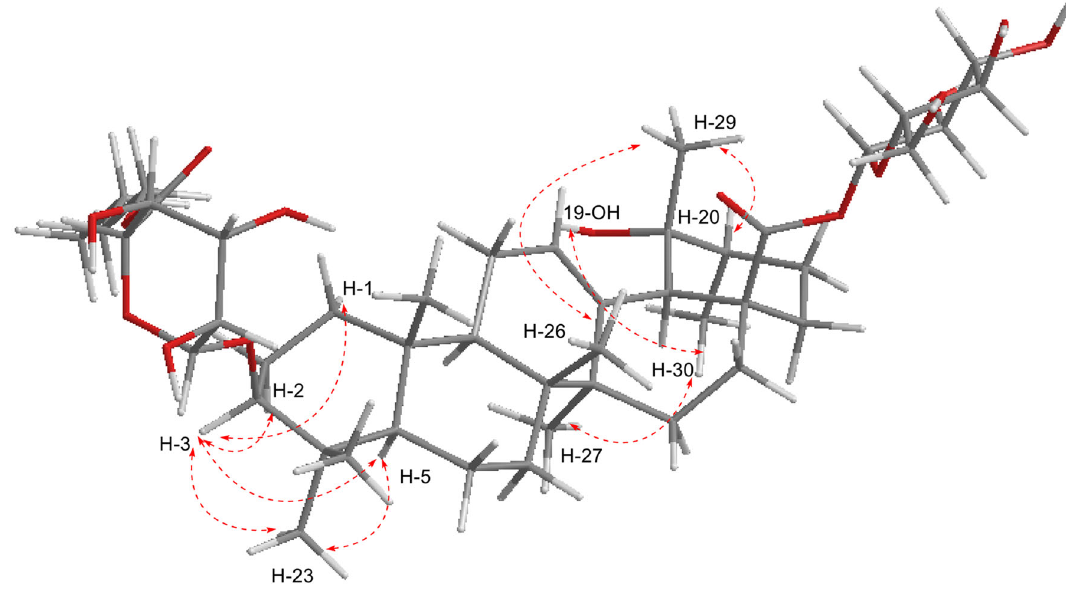
Fig. 3 Key ROESY (red arrow) correlations of compound 1